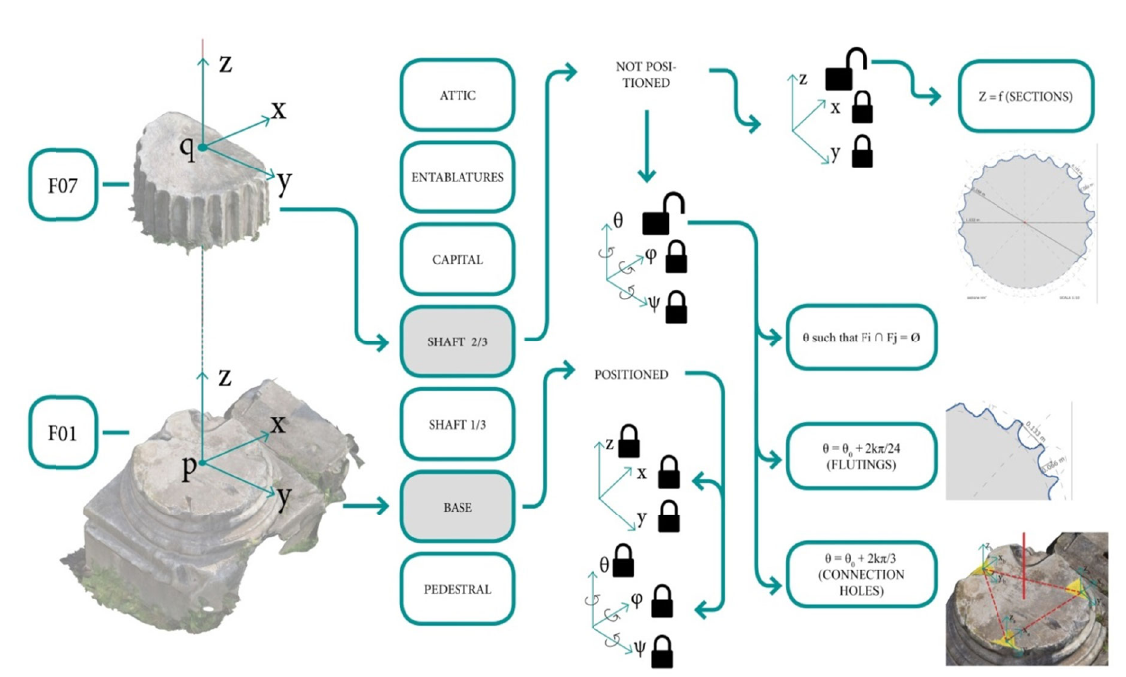
emains of the A Arch of Titus. Sc cheme with the e six degrees of poss sible links, usefu ful for Virtual an